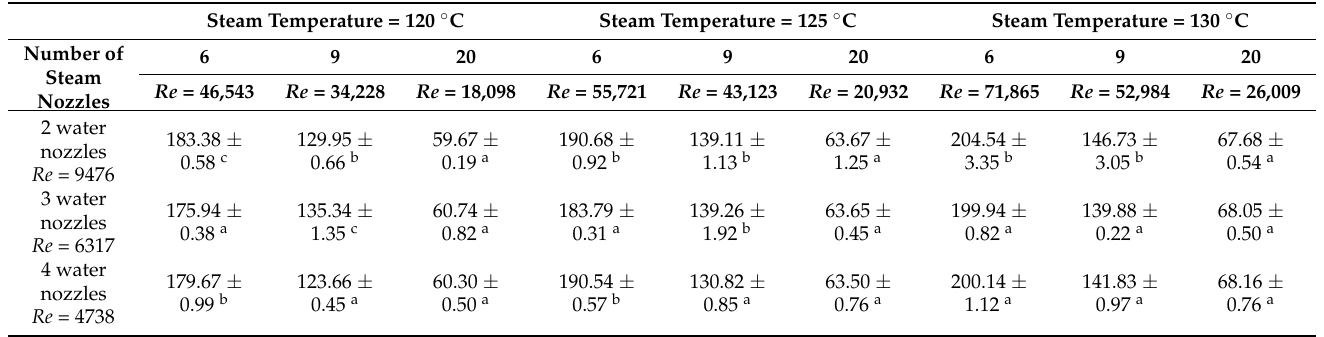
Table 2. The Nusselt number at varied impingement